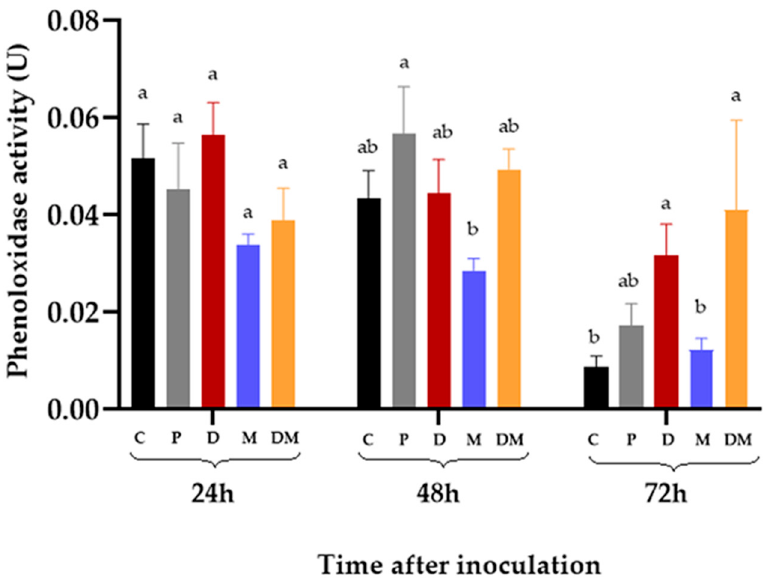
Figure 2. Changes in the phenoloxidase (PO) activity (U) in the hemolymph of Rhipicephalus microplus after injection of dopamine and inoculated Metarhizium anisopliae . Data were represented as means and standard error. Bars with the same letter at the same time did not differ statistically after two-way ANOVA followed by Tukey’s test ( p > 0.05). C: untreated ticks; P: ticks injected with phosphate